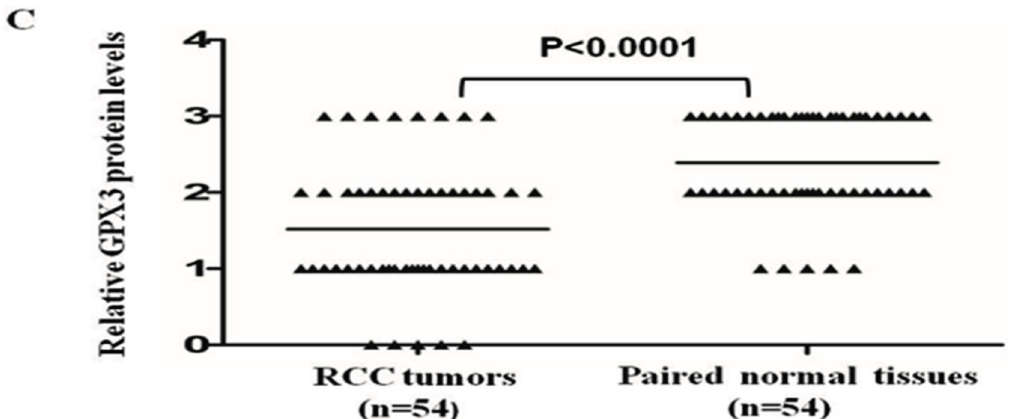
Figure 3. Expression pattern of GPX3 in ccRCC . ( A ) Seventy-six paired ccRCC samples and adjacent non-tumor tissues were analyzed by real time RT-PCR for GPX3 mRNA expression, which was significantly downregulated in ccRCC tumors as compared to adjacent non-tumor samples ( p < 0.0001); ( B ) Representative immunohistochemical staining of a pair of ccRCC specimens and corresponding non-tumor tissue. In adjacent non-tumor tissues, intense immunostaining for GPX3 was detected in a cytoplasmic distribution, whereas absent/weak immunostaining was observed in the cytoplasm of tumor tissues; The place of pictures taken in 400× was indicated by arrows; ( C ) Evaluation and statistical analysis of GPX3 protein expression in 54 paired ccRCC samples and adjacent non-tumor tissues. GPX3 protein expression was significantly downregulated in ccRCC samples compared to adjacent non-tumor tissues ( p <